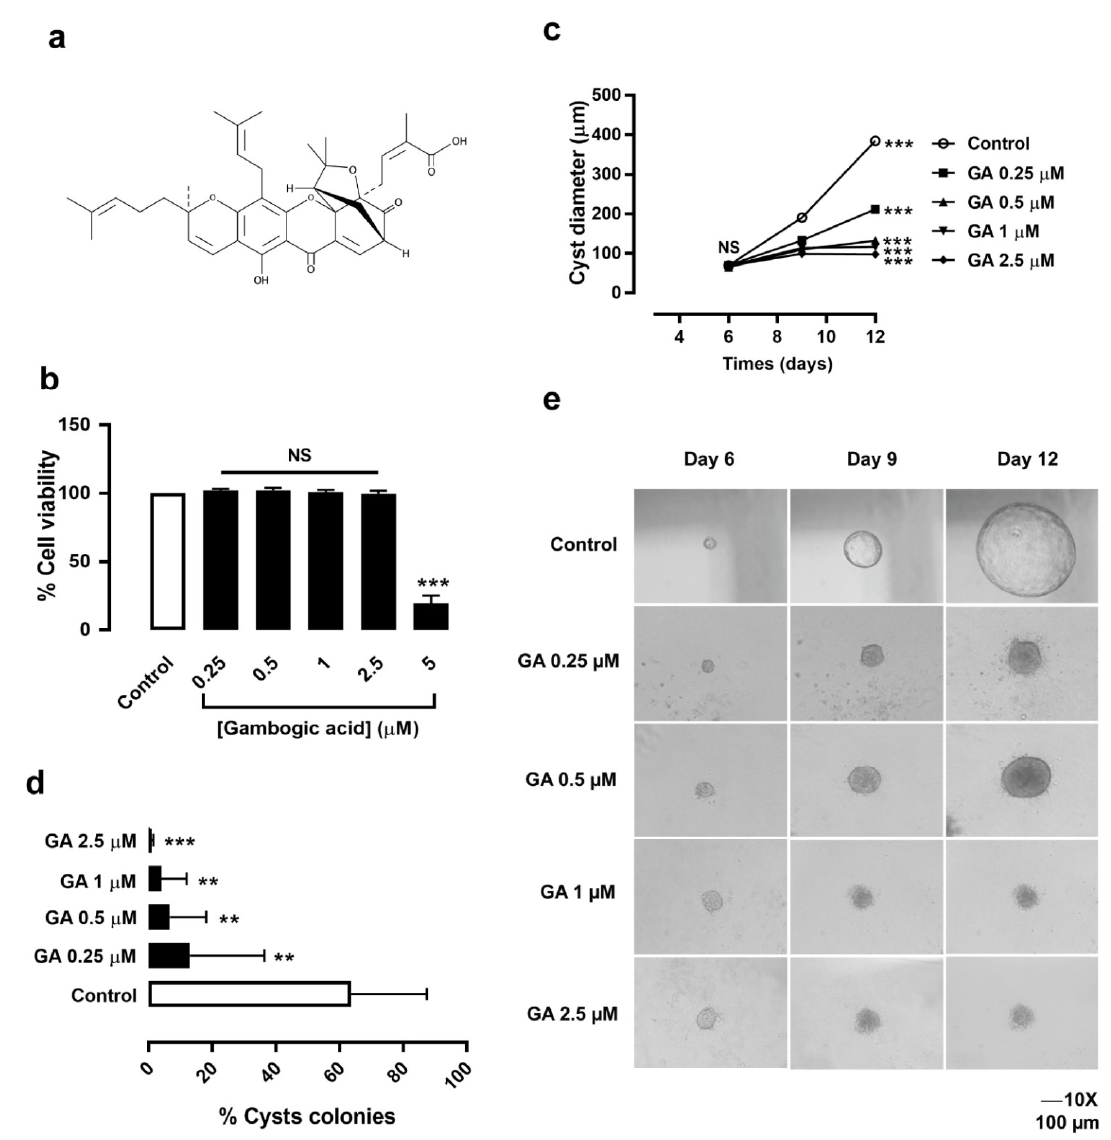
Figure 1. Effect of gambogic acid on MDCK cyst growth and cyst formation. ( a ) Chemical structure of GA. ( b ) MDCK cell viability after incubation with DMSO (control) and GA at doses of 0.25, 0.5, 1, 2.5, and 5 μM for 24 h (mean of percent control ± SEM, n = 4, *** p < 0.001, NS; not significant). ( c ) Inhibitory effect of GA on MDCK cyst growth. The graph shows cyst diameters at day 6, 9, and 12